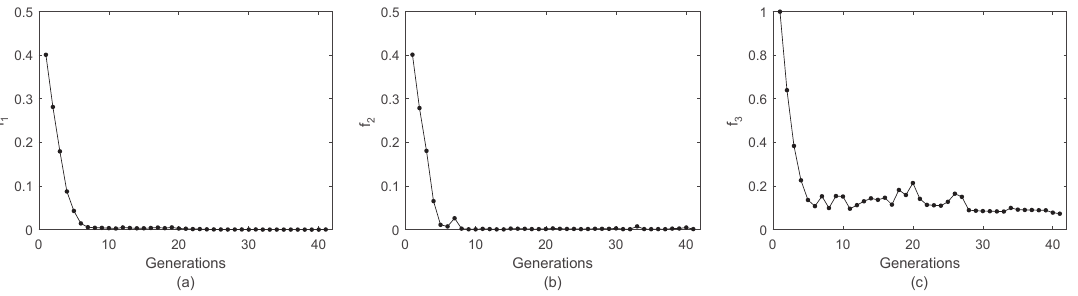
Figure 8. Convergence of the SO optimization of a 3-dimensional DTLZ #2 problem. Panel ( a ) reports the average value of f 1 across the generations for the individuals composing the population. Panels ( b , c ) show the evolution of the average performance for f 2 and f 3 , respectively.